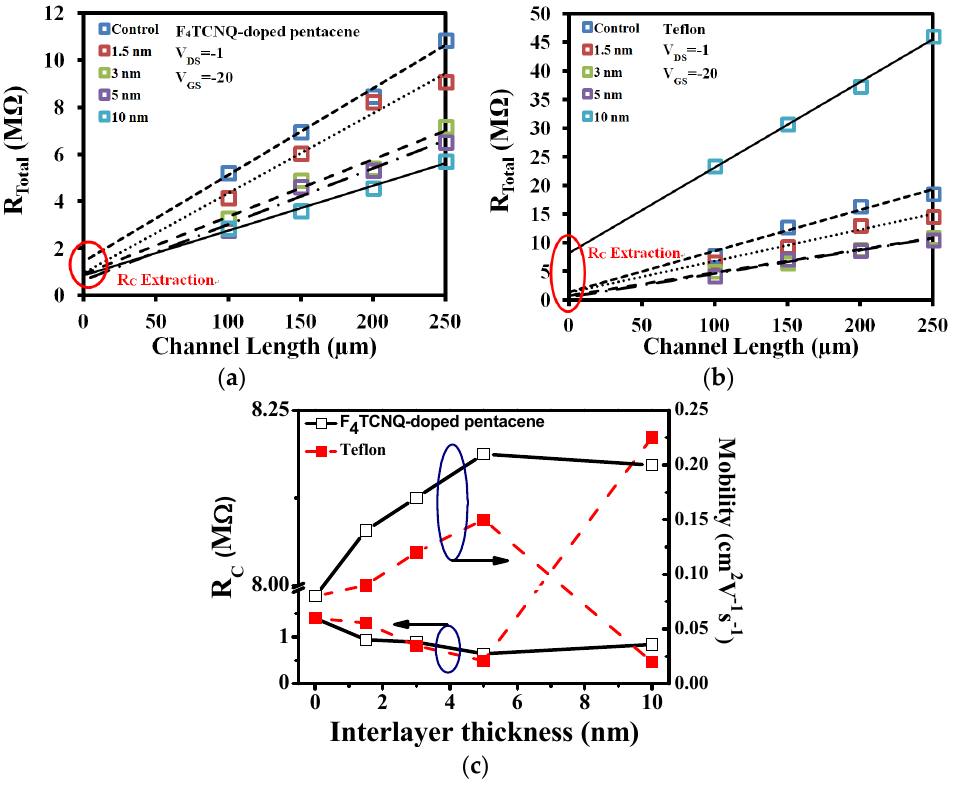
Figure 5. The R Total and R C of pentacene-based OTFTs with the different thickness of the ( a ) F 4 TCNQ-doped pentacene and ( b ) Teflon interlayer. ( c ) The variation of the mobility and R c values with the various carrier-injection interlayer thickness for the devices with F 4 TCNQ-doped pentacene or Teflon interlayers.